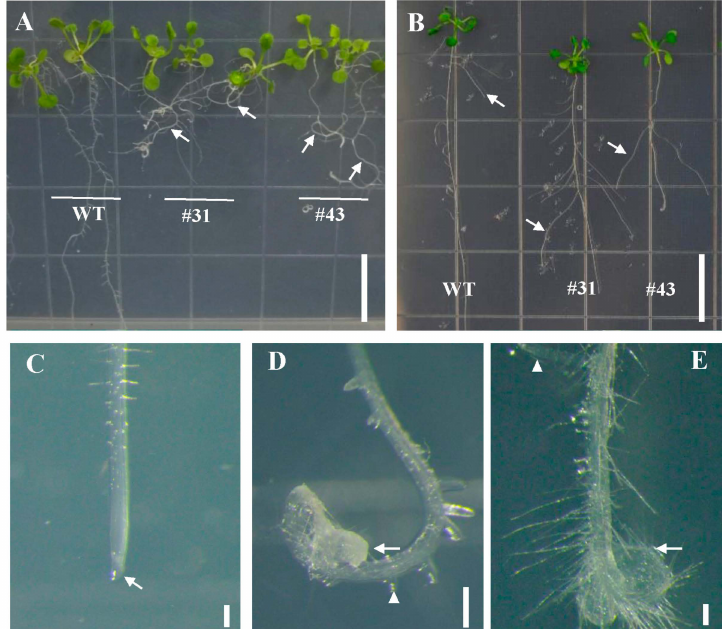
Figure 4. Disordered root morphology and enhanced lateral root length by overexpression of PtoWUSa in Arabidopsis . ( A ) Three-week-old WT and PtoWUSa -overexpressing Arabidopsis plants. ( B ) Comparison of straightening lateral roots (LRs). ( C – E ) The primary root of WT and transgenic plants. Arrows pointed to primary root tip; triangles pointed to LR. Scale bars: ( A , B ) = 1.5 cm; ( C – E ) = 100 µ